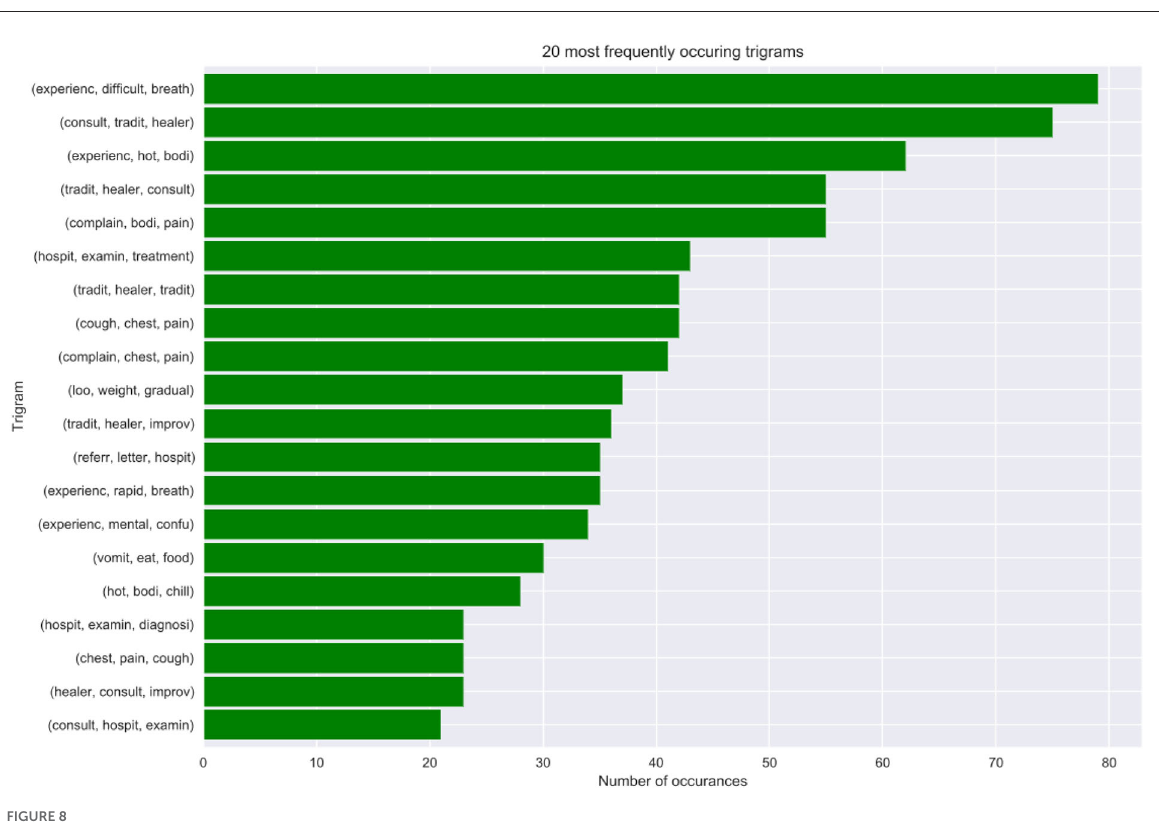
frequency analysis of features (refer to Figure 9). As n increases the features start having more or less the same